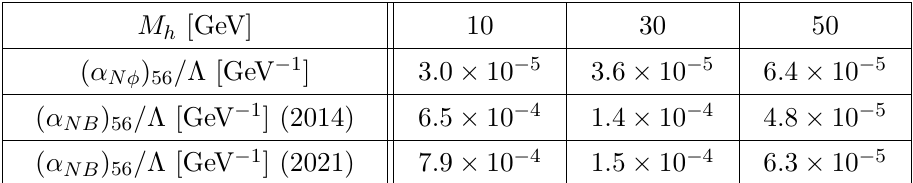
Table 1 . Benchmarks used in our analysis. In the second row we show the effective heavy neutrino coupling to the Higgs α Nφ / Λ giving a H → N 5 N 6 branching ratio of 21% . The third and fourth rows give the value of the dipole couplings α NB / Λ optimal for the searches outlined in sections 5.1 and 5.2,